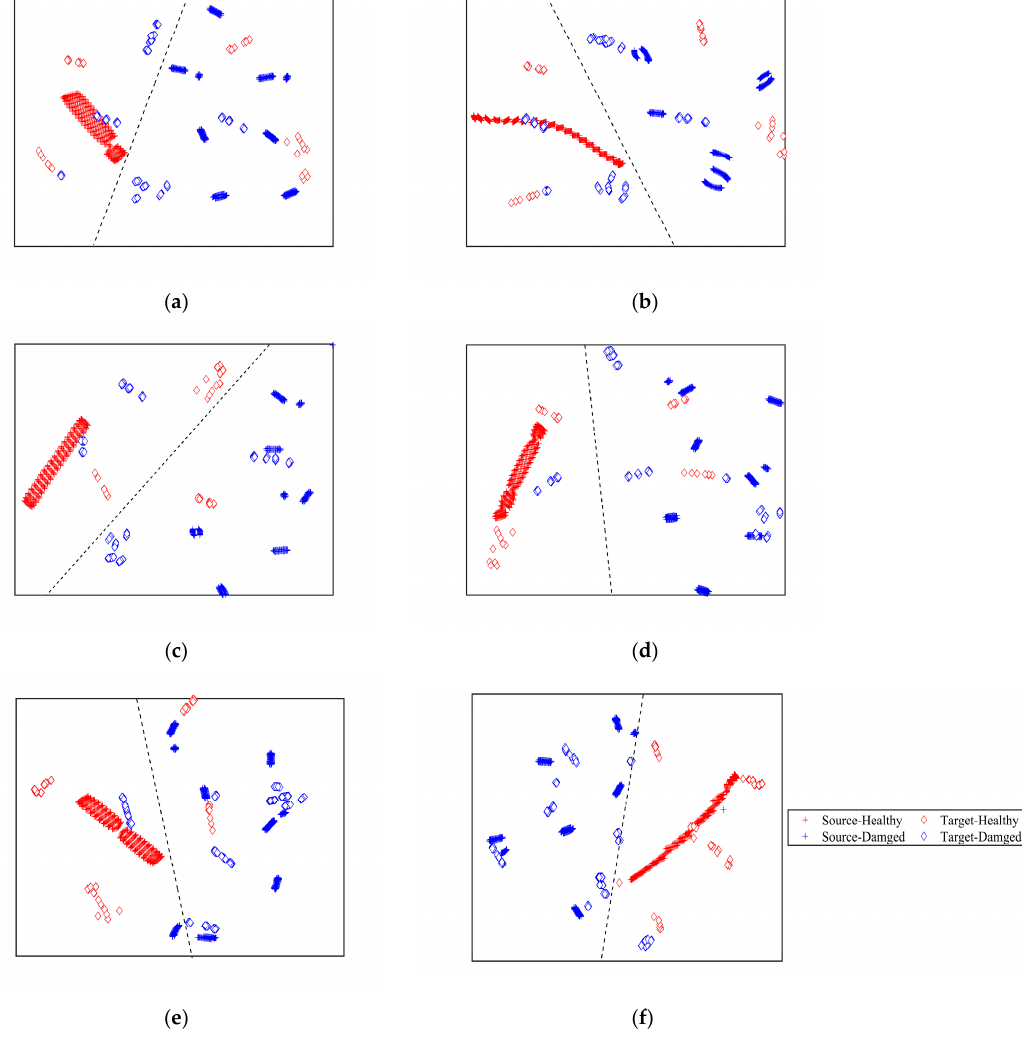
Figure 15. The visualization of the mapped features on the source and target domain: ( a ) 1D-CNN, ( b ) WGAN-GP, ( c ) DDC, ( d ) DAN, ( e ) DANN, and ( f ) MMD-DANN.